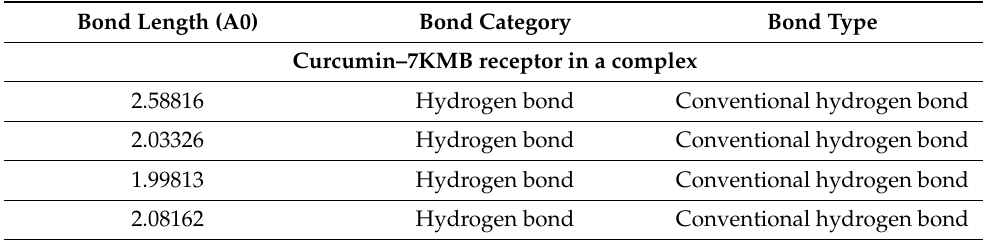
Table 6. The active residues, bond length (A0), bond types, and bond categories involved in the molecular interactions of curcumin with ACE2 receptors (7KMB, 7KNB, and 7KNH) in a complex. Bond Length